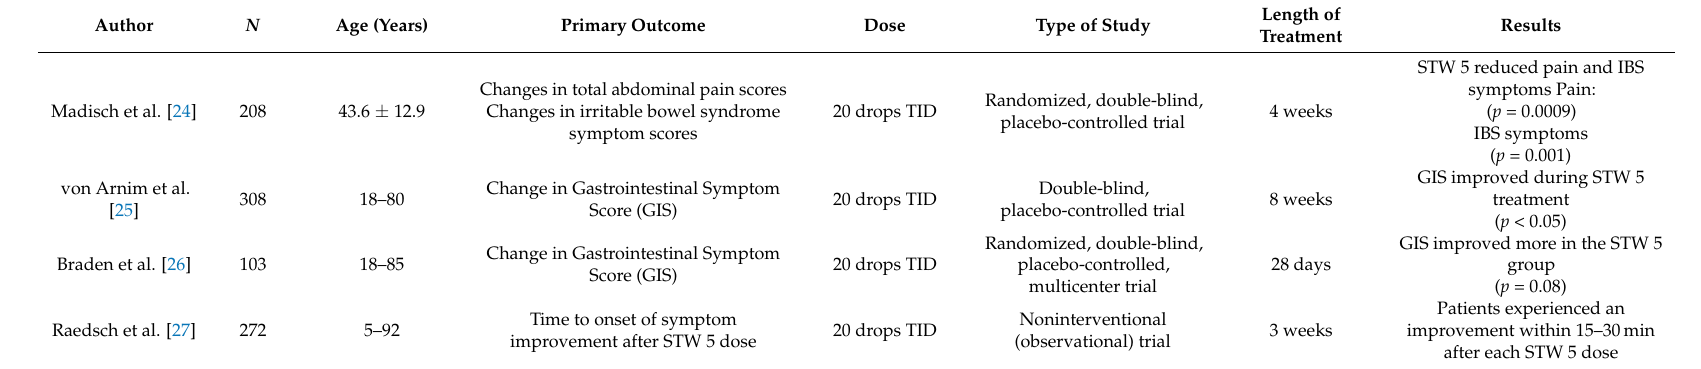
Table 2. Clinical Trials on STW 5 in the treatment of functional gastrointestinal